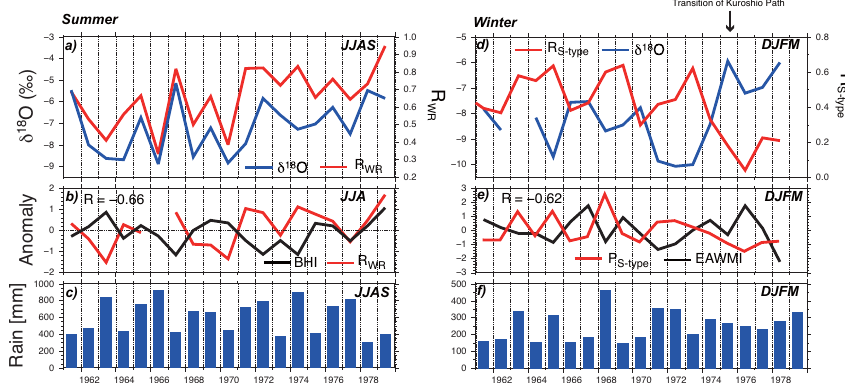
Figure 8. Time series of seasonal average data for the period 1961 to 1979. (a) Precipitation-weighted δ 18 O in summer (June–September) precipitation at Tokyo station and the ratio of the warm rainfall to the total summer precipitation R WR . (b) The R WR anomaly during boreal summer (June–August) and the Bonin High index (BHI) normalized by standard deviation. (c) The total summer precipitation amount at a meteorological station located near the GNIP Tokyo station. (d) Same as (a) , but for winter (December–March) precipitation and for the ratio of the southern coastal cyclone to total winter precipitation R S-type . (e) Same as (b) , but for R S-type anomaly during winter and for East Asian Winter Monsoon index (EAWMI). (f) Same as (c) , but for winter precipitation.